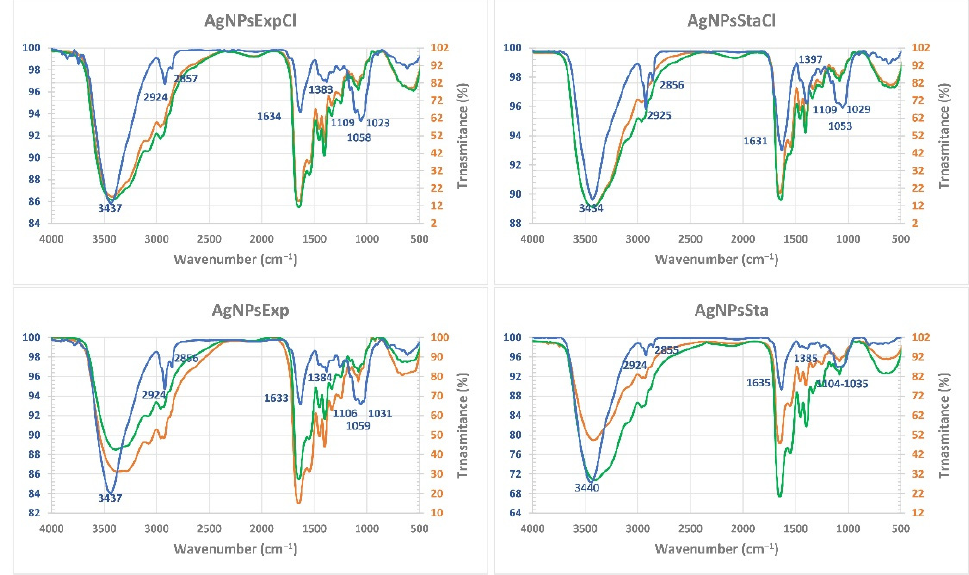
Figure 7. Characterization of the corona components of AgNPs and broths. AgNPs’ spectra are shown in blue; the broths before synthesis are in orange and after synthesis in green. The wavenumber of the principal bands of AgNPs are indicated.